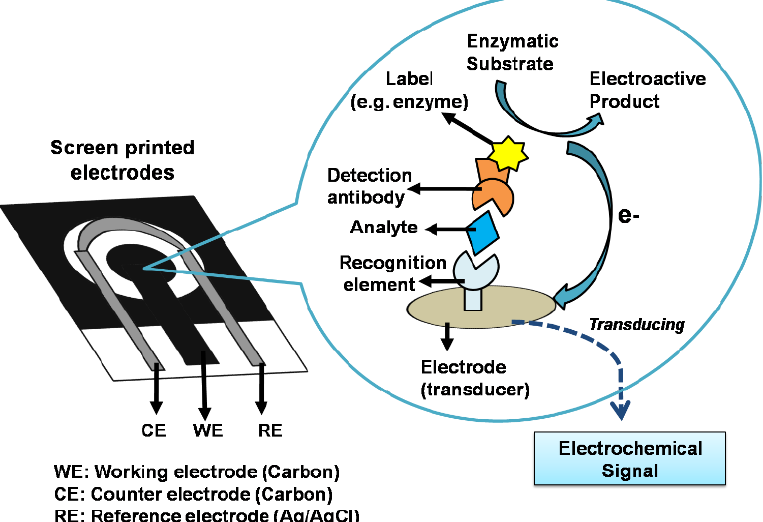
Figure 4. Screen-printed-electrode based electrochemical biosensor. Typical interactions on the working electrode among the biorecognition element, target analyte and detection antibody labelled with an enzyme. As shown, the enzyme oxidises an enzymatic substrate to produce an electroactive product that releases electrons, which are transduced as a measurable electrochemical signal.